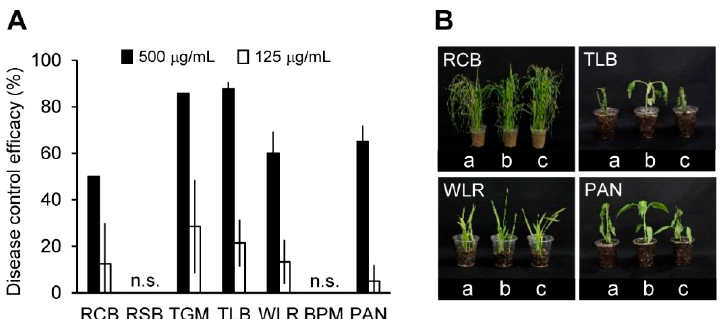
Figure 6. In vivo antifungal activities of crinipellin A ( 1 ). ( A ) Plant disease inhibitory effects of